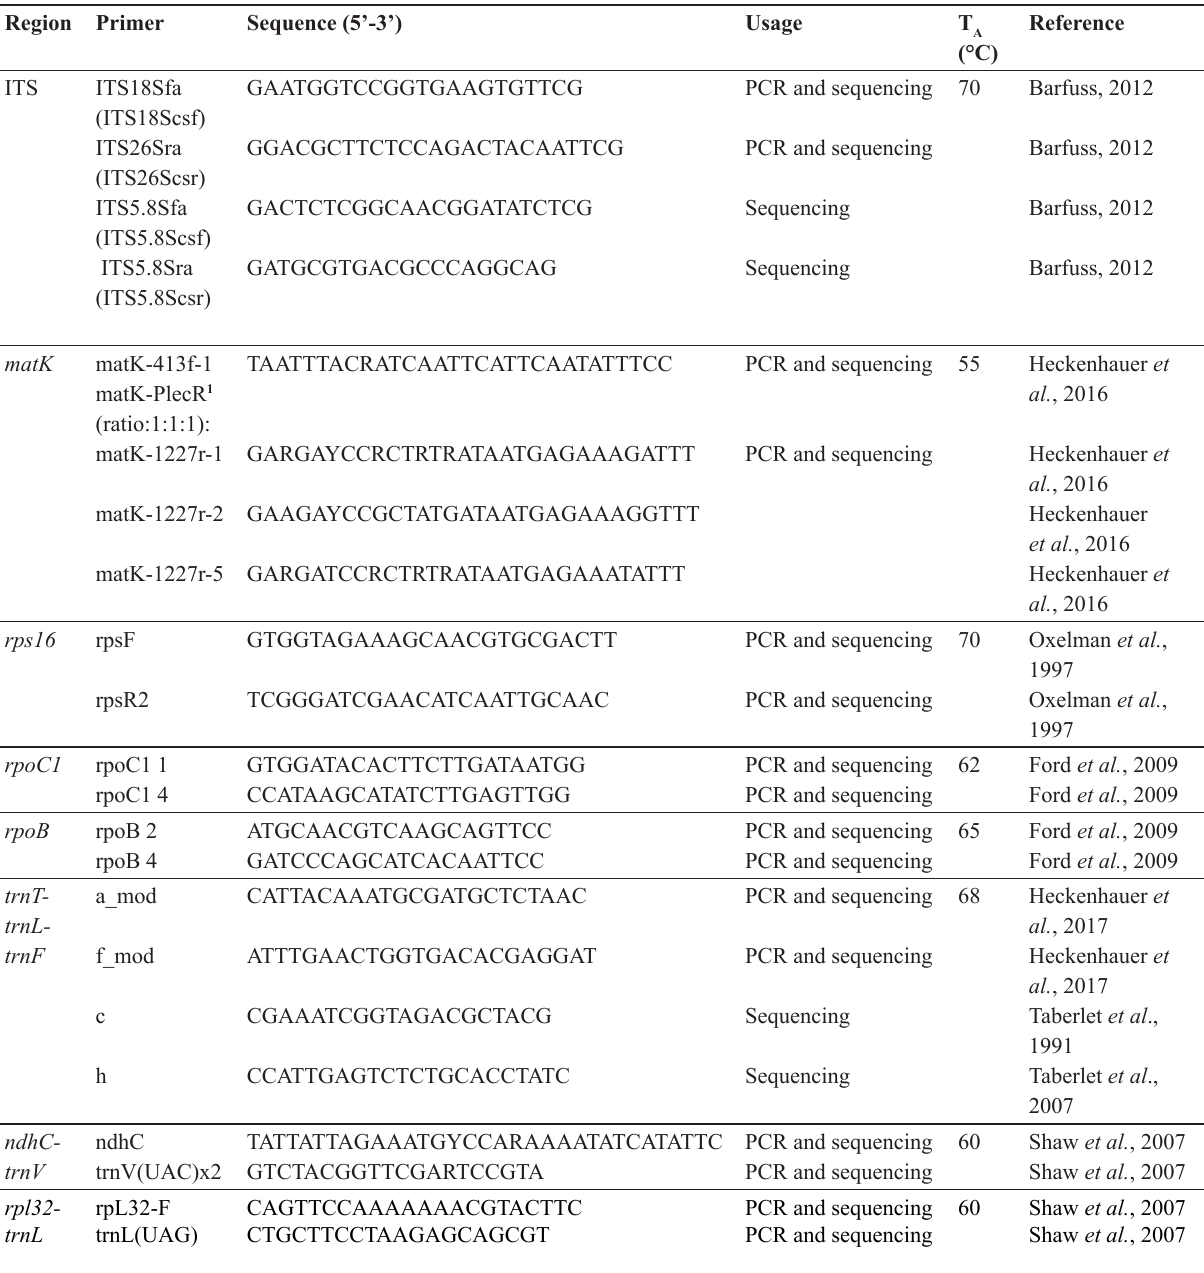
Table 2: Details of primers used in this study . Region Primer Sequence